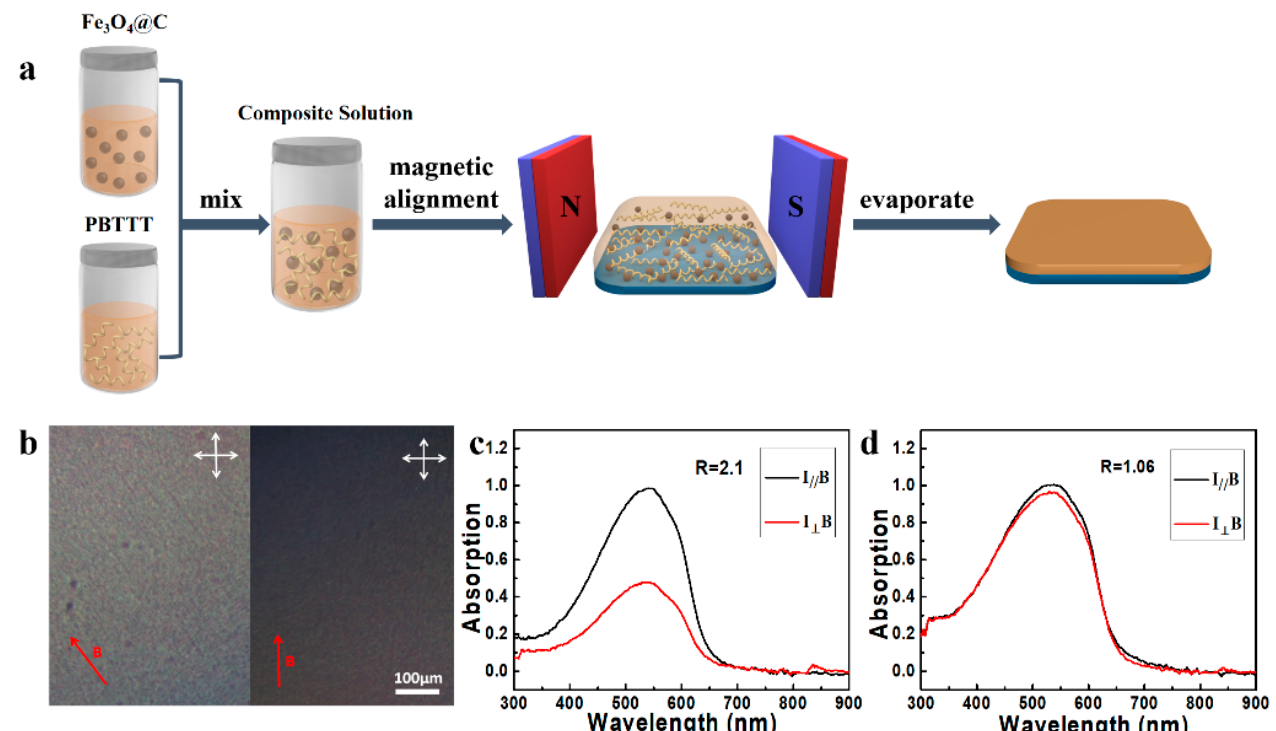
Figure 2. ( a ) Schematic illustration of the methodology for the formation of the composite film via magnetic alignment method; ( b ) The POM images of the magnetically aligned Fe 3 O 4 @C/PBTTT com- posite film. The red arrows denote the magnetic field direction; Polarized UV–vis absorption spectra of the PBTTT film, which magnetically aligned with ( c ) and not with ( d ) Fe 3 O 4 @C nanoparticles, respectively.